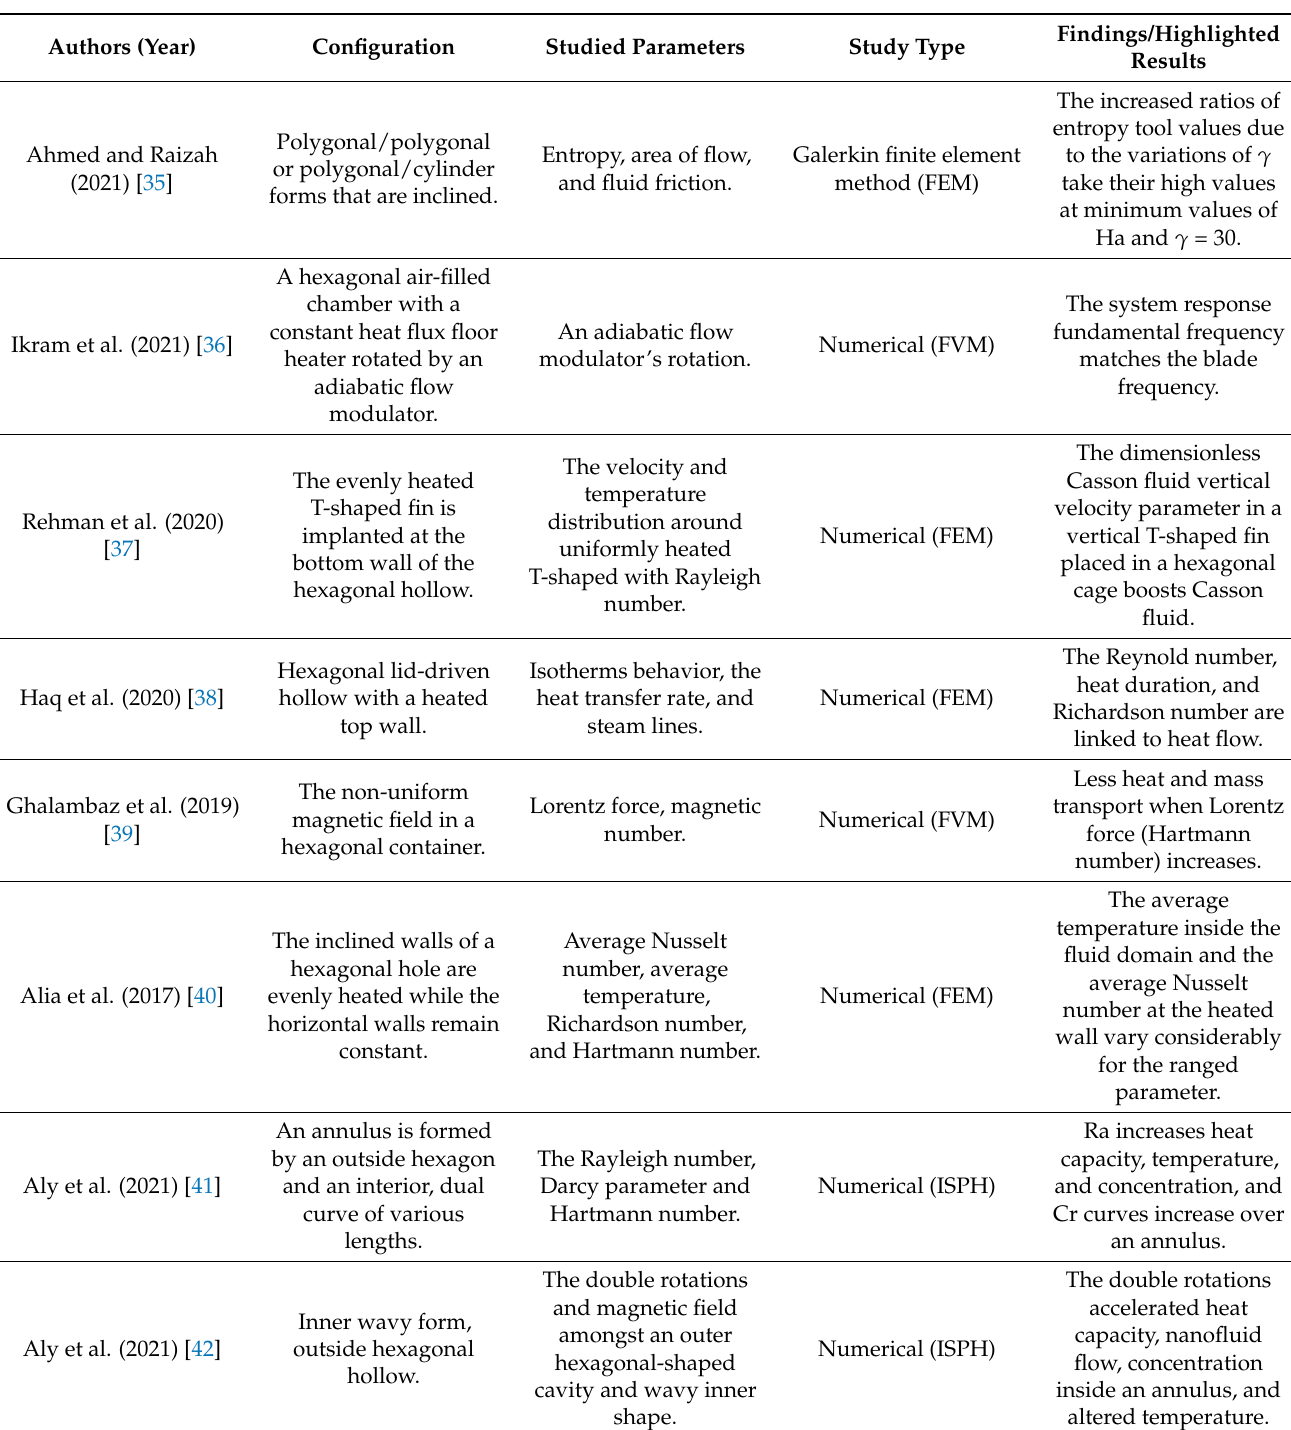
Table 3. Summary of review on hexagonal